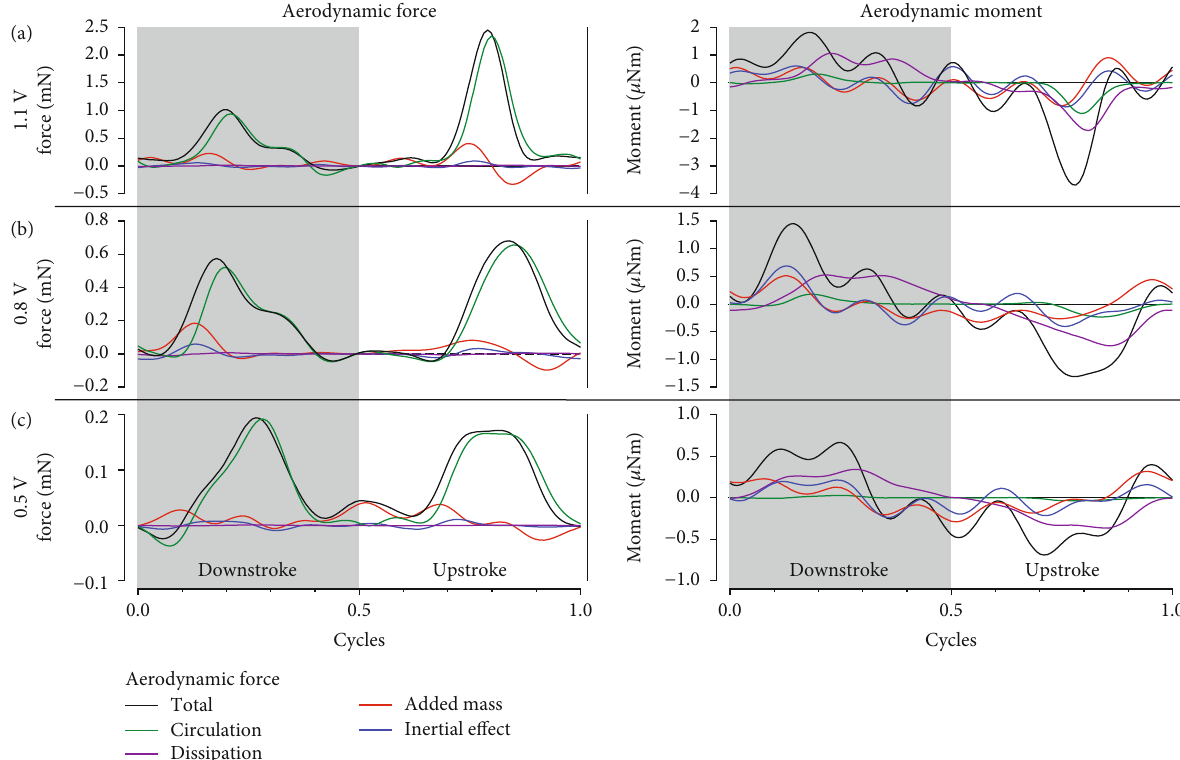
-axis 3 F and moment along the x Aero, y 3